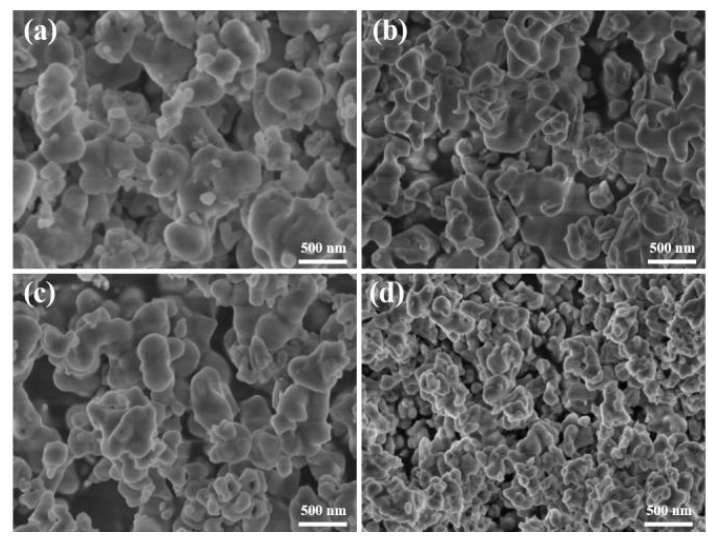
Figure 12. Effect of polyethylene glycol on the microstructure of the sample. ( a ) 5 mL; ( b ) 10 mL; ( c ) 15 mL; and ( d ) 20 mL. Table 5. Particle size distribution of the sample when adding polyethylene glycol. Amount of Polyethylene Glycol